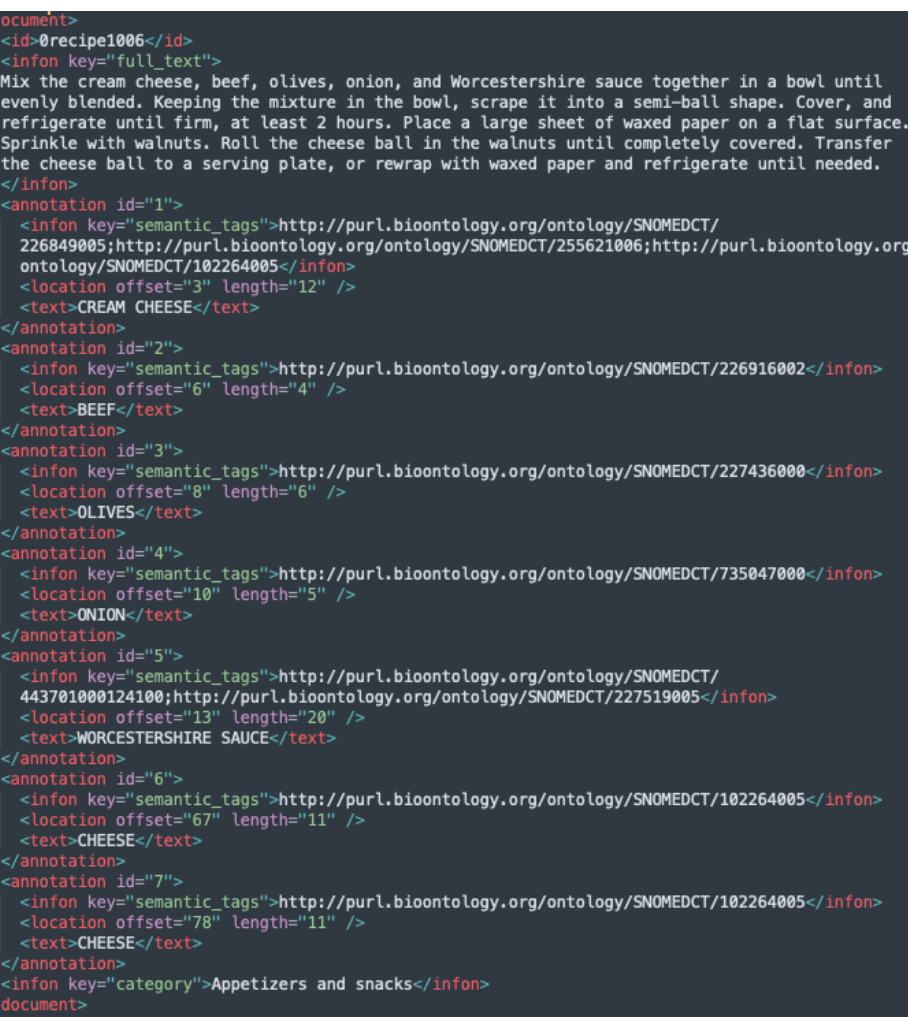
Figure 4. Example of an instance from FoodBase annotated with tags from the SNOMED CT